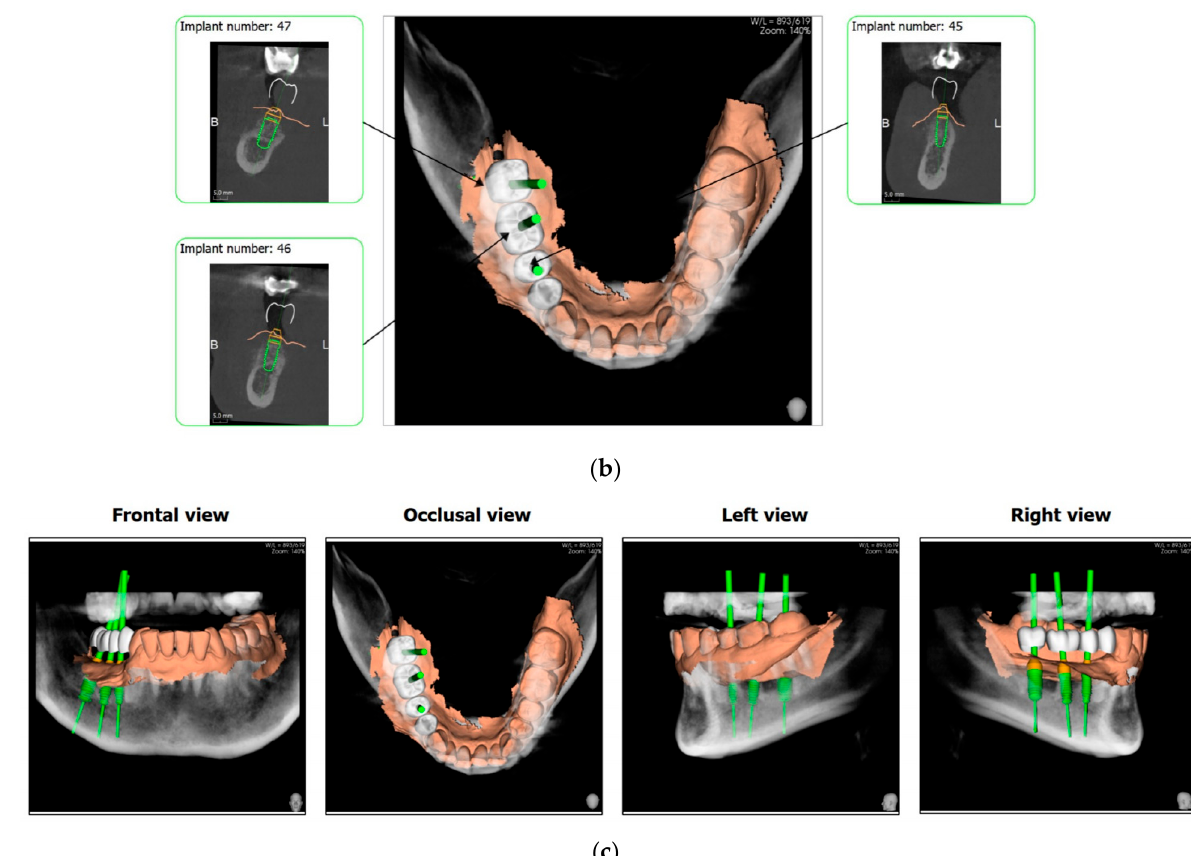
Figure 13. ( a – c ) Implant planning.